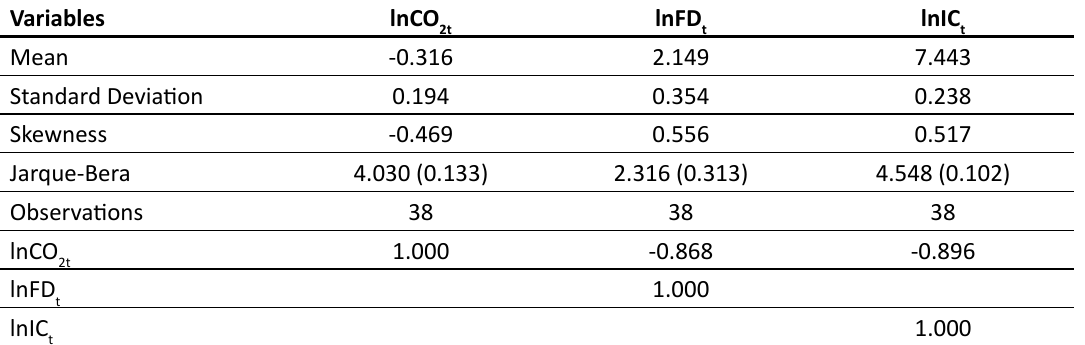
Table 2: Descriptive Statistics and Correlation Analysis